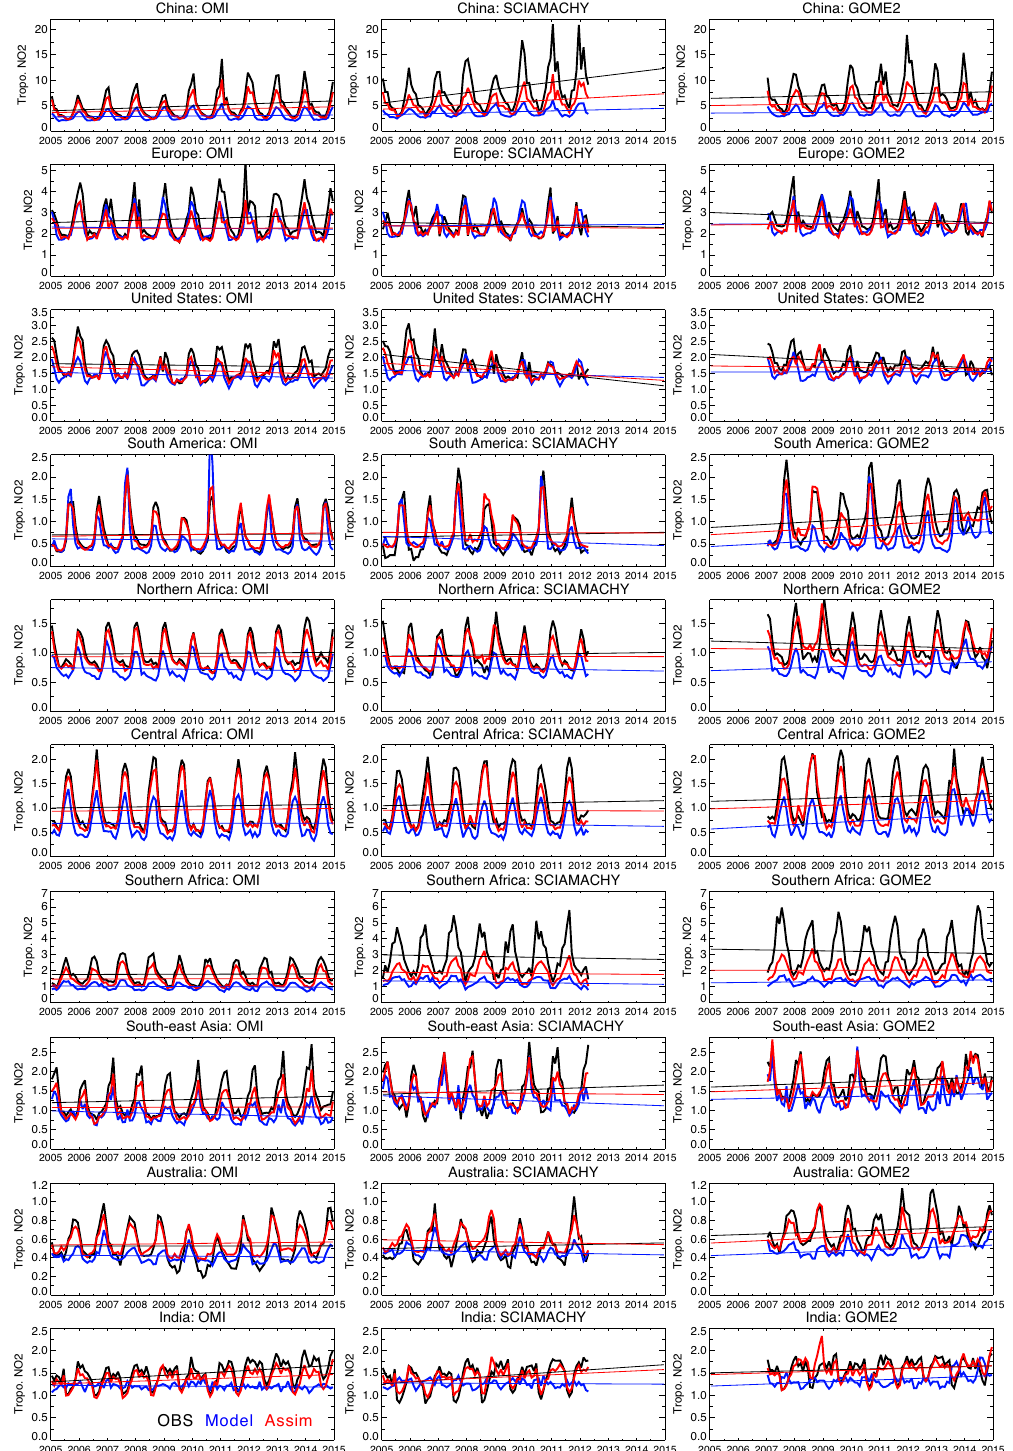
Figure 3. Time series of regional monthly mean tropospheric NO 2 columns (in 10 15 moleccm − 2 ) averaged over China (110–123 ◦ E, 30– 40 ◦ N), Europe (10 ◦ W–30 ◦ E, 35–60 ◦ N), the USA (70–125 ◦ W, 28–50 ◦ N), South America (50–70 ◦ W, 20 ◦ S–Equator), northern Africa (20 ◦ W–40 ◦ E, Equator–20 ◦ N), central Africa (10–40 ◦ E, Equator–20 ◦ S), southern Africa (25–34 ◦ E, 22–31 ◦ S), South-east Asia (96– 105 ◦ E, 10–20 ◦ N), Australia (113–155 ◦ E, 11–44 ◦ S), and India (68–89 ◦ E, 8–33 ◦ N) obtained from the satellite retrievals (black), model simulation (blue), and the data assimilation (red). The model simulation and data assimilation results were obtained at the local overpass time of the retrievals by applying the averaging